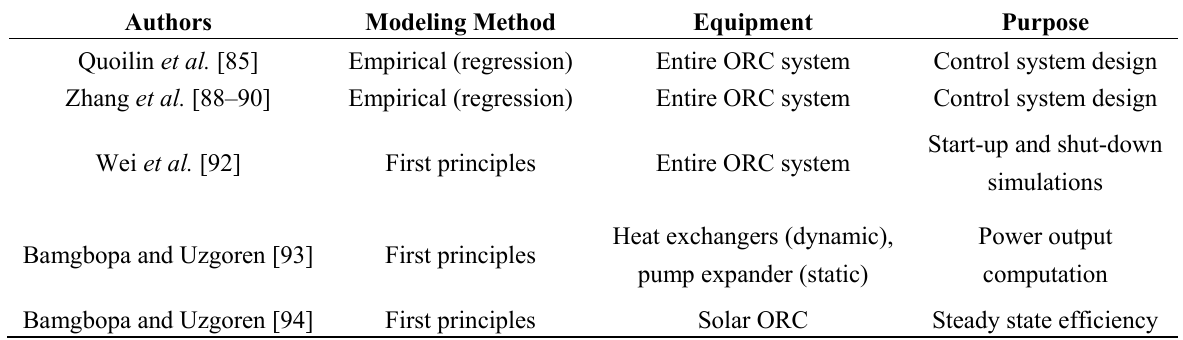
Table 8. Dynamic modeling